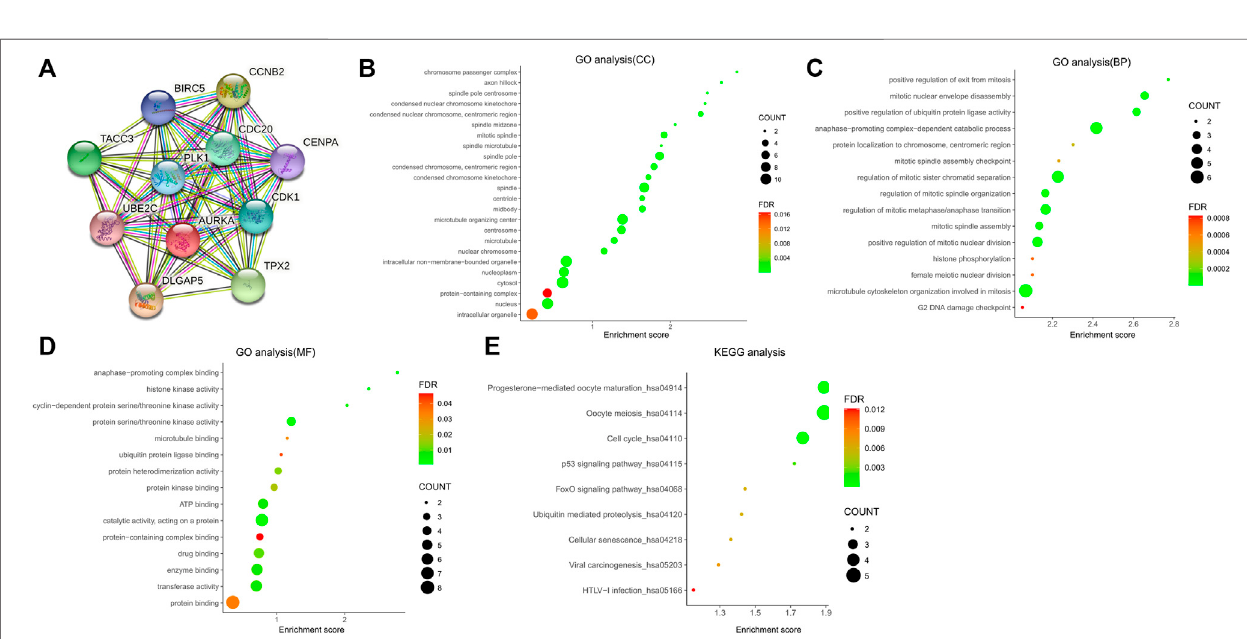
FIGURE 3 | PPI network of AURKA and AURKA-related genes. (A – D) GO analysis of AURKA and AURKA-related genes. (E) KEGG pathway analysis of AURKA and AURKA-related genes.